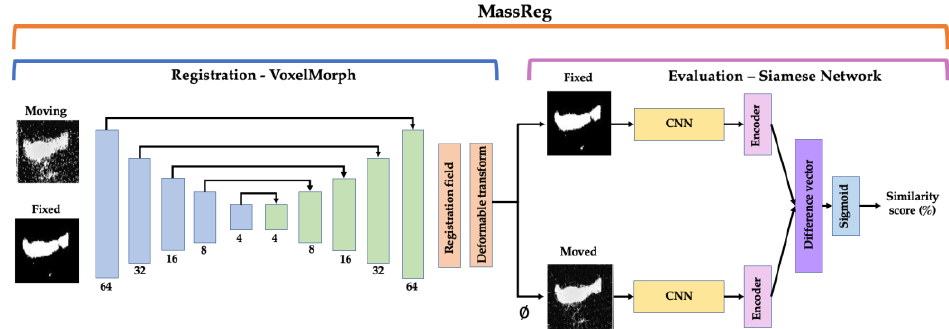
Figure 2. Overall network architecture for MassReg. Left half — VoxelMorph framework for registration. This network is based on a U-Net which is an encoder/decoder network with skip connections. Right half — Siamese network for evaluation. This architecture consists of two identical convolutional neural networks (CNNs), that feed into two encoders, a difference vector and finally a sigmoid activation function. The input to the network is a DESI/histology image pair and the output is the registered image pair and a similarity score.